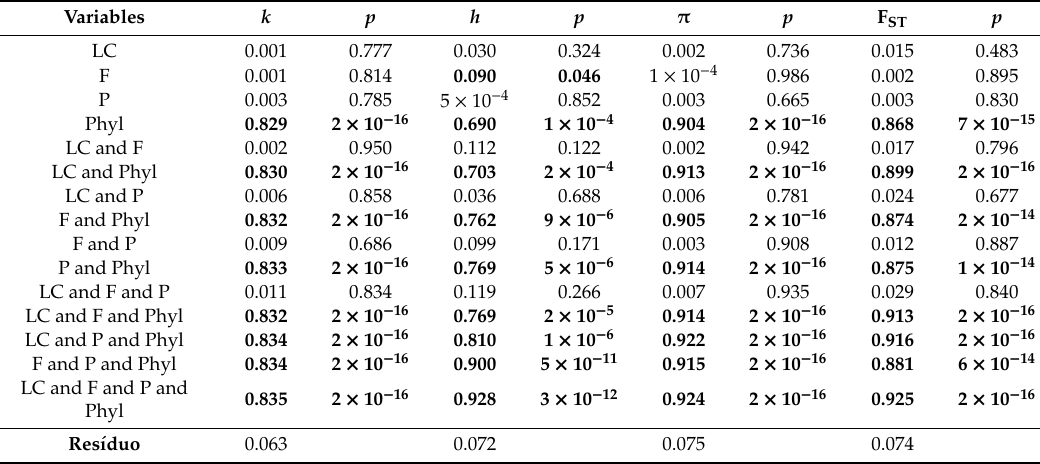
Table 2. Values of R 2 and p calculated for the influence of phylogeny and reproductive variables, and the di ff erent combinations of these variables, on the genetic diversity ( k , h and π ) and F ST of plants. The data were obtained from studies that used cpDNA markers for the analysis of genetic diversity. Variables k p h p π p F ST p LC 0.001